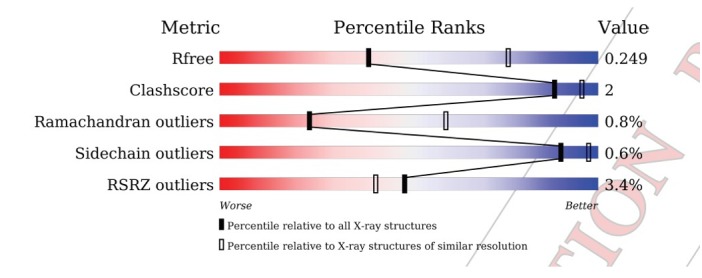
DOI:
http://dx.doi.org/10.7554/eLife.22567.030